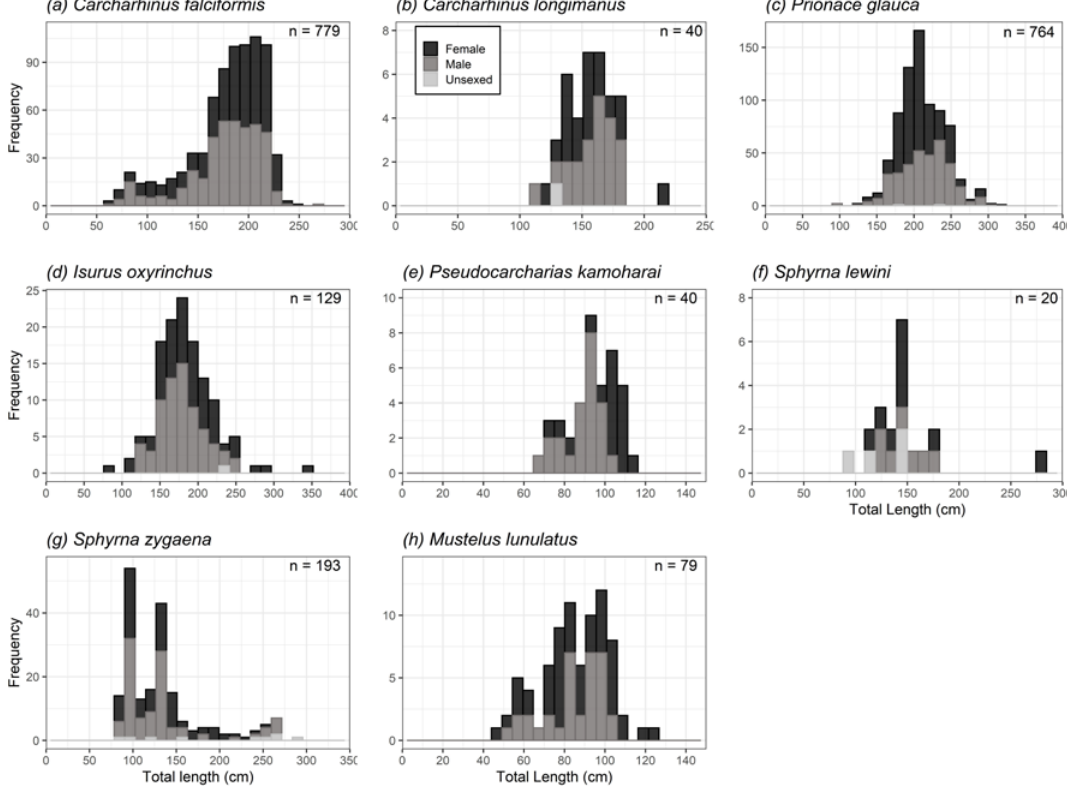
Figure 3. Composition of sizes of shark species (n ≥ 20) landed in Manta: ( a ) Carcharhinus falciformis ; ( b ) Carcharhinus longimanus ; ( c ) Prionace glauca ; ( d ) Isurus oxyrinchus ; ( e ) Pseudocarcharias kamoharai ; ( f ) Sphyrna lewini ; ( g ) Sphyrna zygaena ; ( h ) Mustelus lunulatus . The claspers of 361 C. falciformis were measured, of which 153 were not calcified (66–186 cm TL and 1–15 cm CL), 21 were semicalcified (168–195 cm TL and 11–21 cm CL), and 187 were calcified (164–272 cm TL and 16–33 cm CL) (Figure 4a). The estimates of L 50 and L 95 for males were 182.38 cm TL ± 1.07 S.E. and 196.29 cm TL ± 2.99 S.E., respectively (Figure 5a). The inflexion point was estimated at 188.2 cm